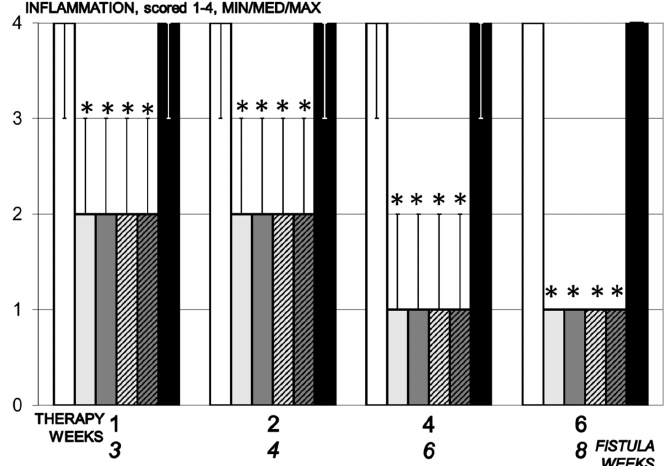
Figure 8. Inflammation, scored 1–4, min/med/max, time line. Therapy regimens starting at the day 14 after fistula creation (therapy day 0), included BPC 157 given once daily intraperitoneally, last application at 24 h before sacrifice, 10 µg/kg (light gray bars) or 10 ng/kg (dark gray bars) or given perorally, in drinking water 10 µg/kg/day (dashed light gray bars) or 10 ng/kg (dashed dark gray bars) until the sacrifice. Controls received simultaneously an equal volume of saline (5 mL/kg) intraperitoneally (white bars) or drinking water (12 mL/rat/day) (black bars). * p < 0.05, relative to control.